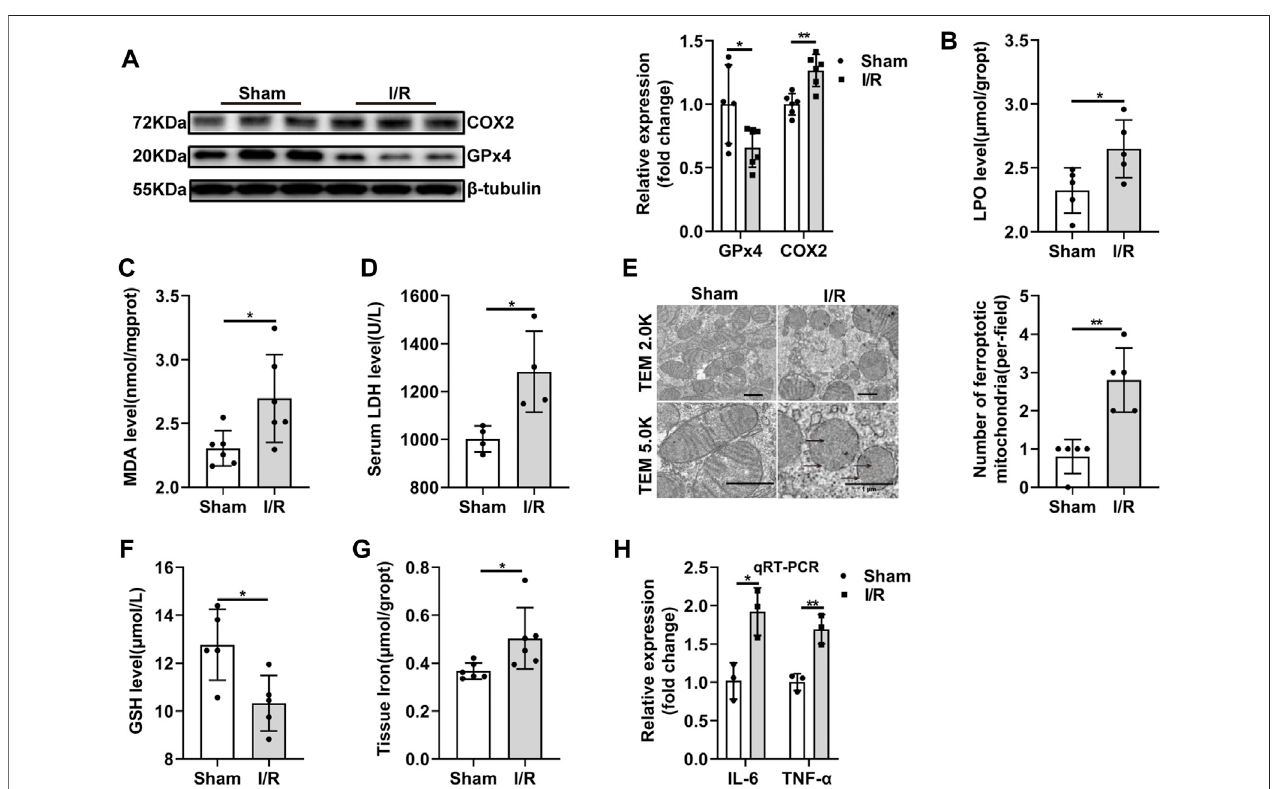
FIGURE2| Ferroptosisand in fl ammation areinvolvedin renalI/R. (A) Validation ofGPx4and COX2 protein expression bywesternblotanalysis( n =6). (B – D) LPO ( n = 5), MDA ( n = 6), LDH ( n = 4) were measured from each group. (E) Representative TEM images (original magni fi cation, × 2.0K or × 5.0K,scarle bar = 1 μ m) and quanti fi cation were shown ( n = 5). The black arrows indicate the decline or disappearance of mitochondrial cristae and the rupture of outer mitochondrial membrane (F,G) Tissue GSH ( n = 5) and tissue iron content (n = 6) were measured from each group. (H) Validation of IL-6 mRNA, and TNF- α mRNA expression by qRT-PCR analysis ( n = 3). The data are the Means ± S.D., * p < 0.05, ** p < 0.01.